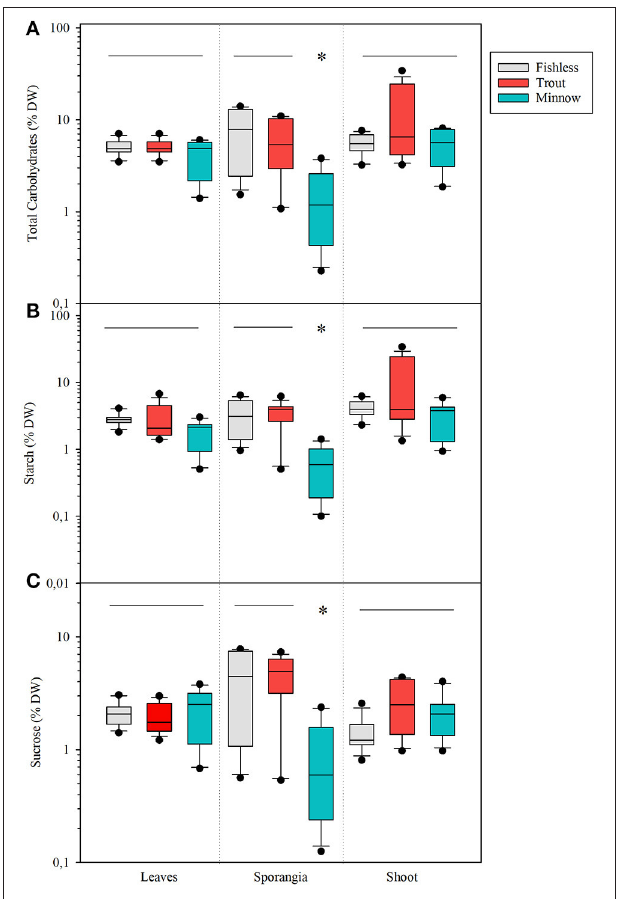
FIGURE 8 | Box plots for (A) total carbohydrate content as % DW, (B) total starch content as % DW, and (C) total sucrose content as % DW in quillwort sorted by plant compartments (leaves, sporangia and corms) under the different scenarios: fishless in gray, with tout in red, and with minnows in blue. Significant differences are set at p < 0.01. Asterisks denote significantly different from the rest and the horizontal line indicates groups not significantly